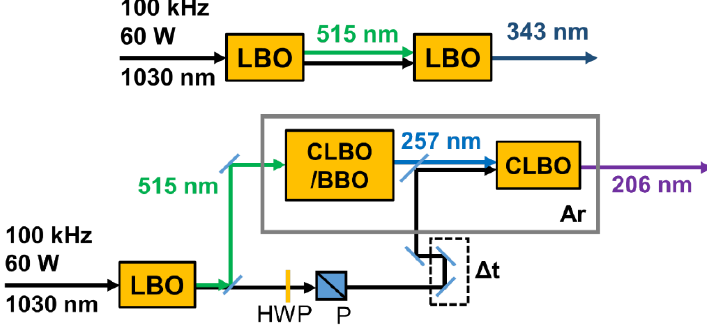
Figure 5. Optical scheme of the frequency conversion system to visible and UV radiation. Second and third harmonic frequency conversion ( top ); fourth and fifth harmonic frequency ( bottom ). LBO: lithium triborate; CLBO: cesium lithium borate; BBO: beta barium